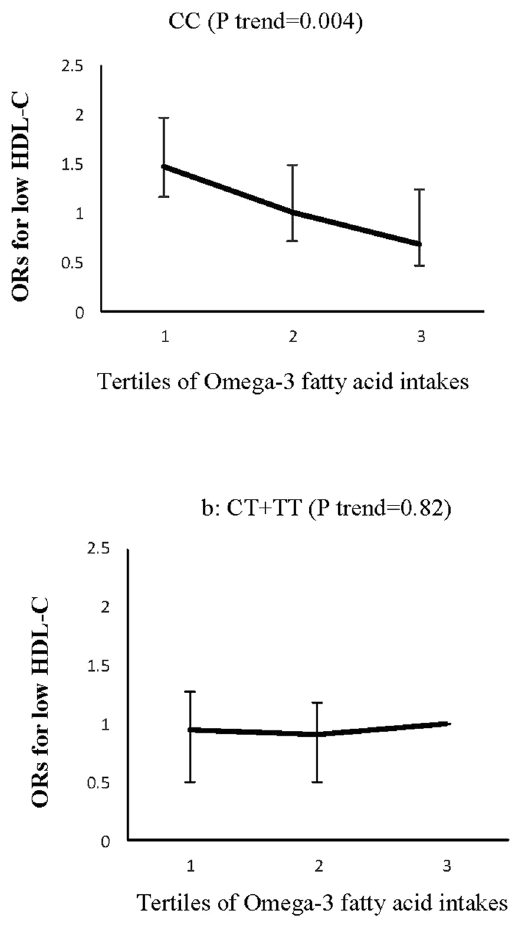
Figure 4. Adjusted ORs for low HDL-C to tertiles of omega-3 fatty acid intake by the ZNT8 genotypes (P interaction = 0.02); CIs are shown after the bootstrap analysis, (T1 < 0.38, T2:0.38–0.54., T3 > 0.54%of energy). The risk of low HDL-C decreased across tertiles of omega-3 fatty acid intakes in CC genotype carriers ( a ), a trend not observed in CT + TT genotype groups ( b